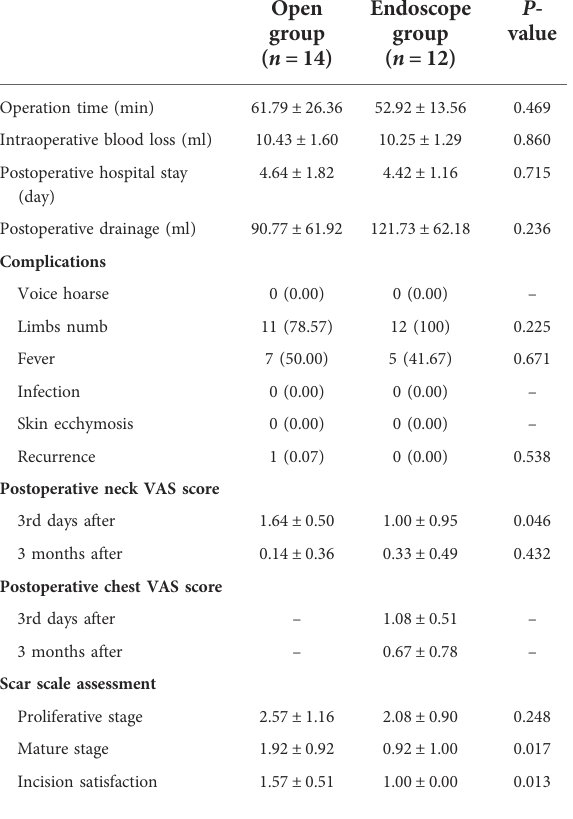
TABLE 2 Comparison of intraoperative and postoperative conditions.